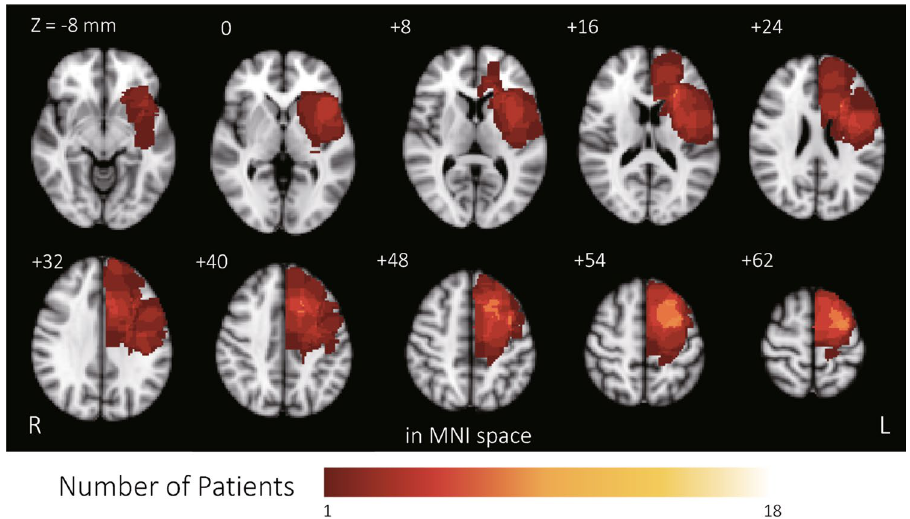
Figure 1. Lesion topography of 18 patients with left frontal gliomas in Montreal Neurological Institute space. Each voxel was identified as part of the tumor region from at least one patient. The color bar represents the number of patients with a lesion on a specific voxel.